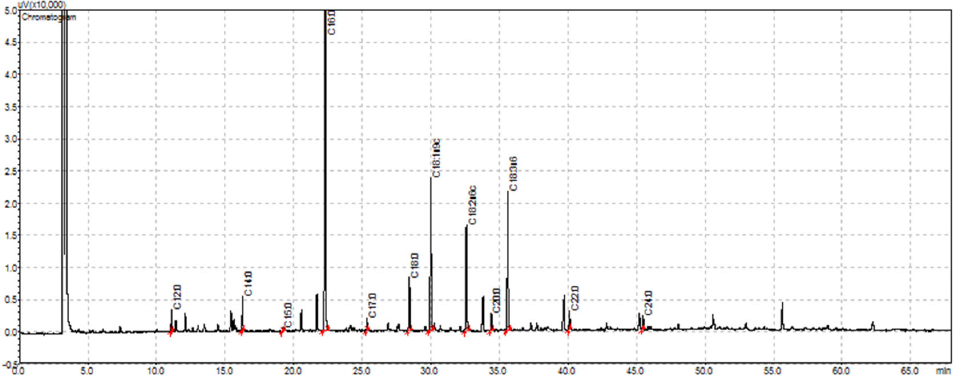
Figure 2. Example of a chromatogram obtained for the fatty acid profile of quince leaves